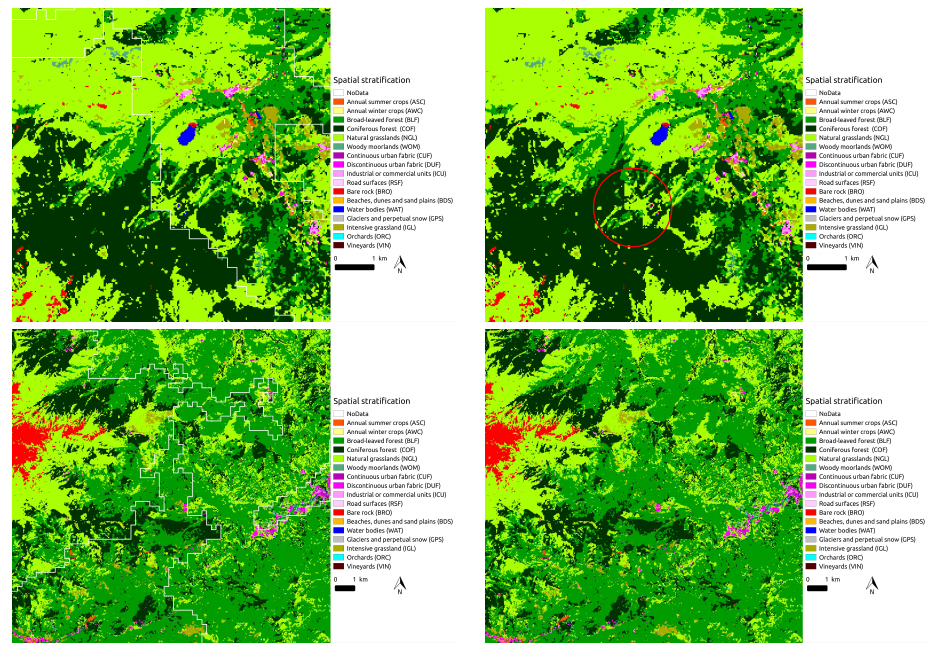
Figure 24. Analysis of artefacts due to eco-climatic stratification. The red circle shows errors due to the boundaries of climatic areas for the upper row example. The lower row example does not show